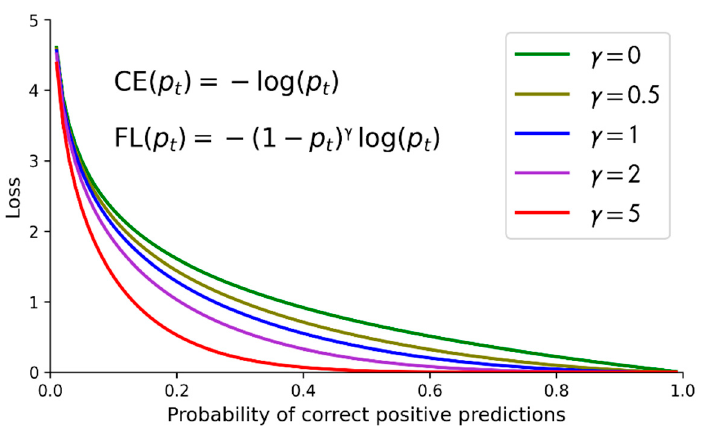
Figure 6. The comparisons of the CE and the FL with different values of γ .